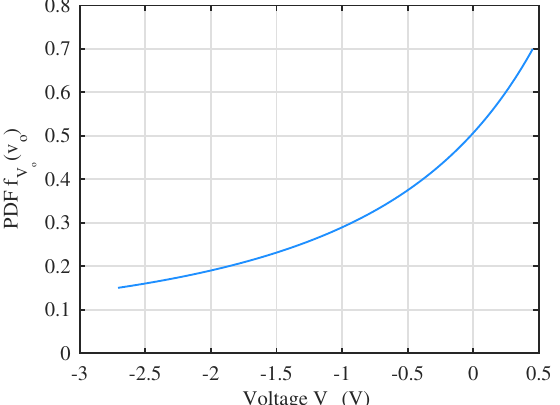
( v o ) when L is a uniform, ( a , b ) , continuous o H, b = 3 4 4